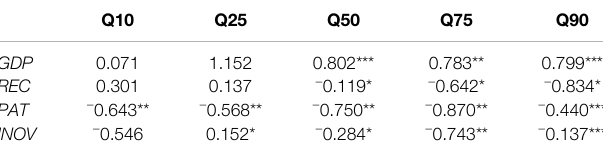
TABLE 6 | Quantile regressions at each quantile. TABLE7| RobustnesscheckwithdifferenceGMM(DGMM)andFGLSestimates.